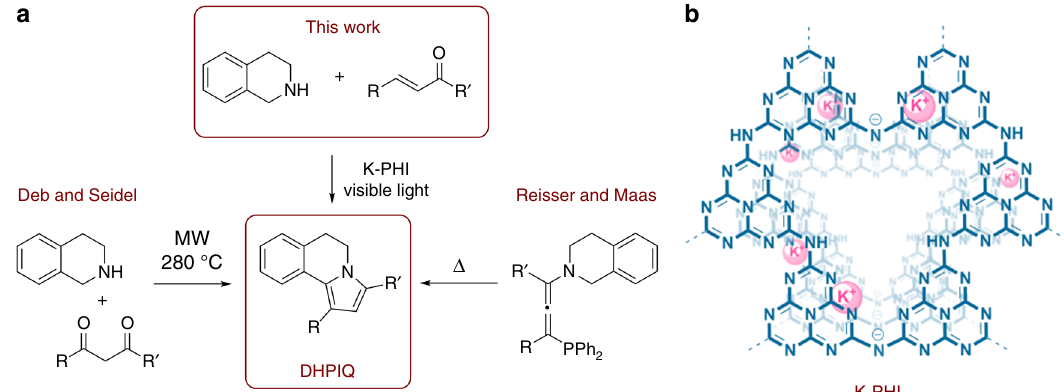
Fig. 1 Key points of the work. Synthetic approaches to the DHPIQs ( a ) and chemical structure of K-PHI ( b